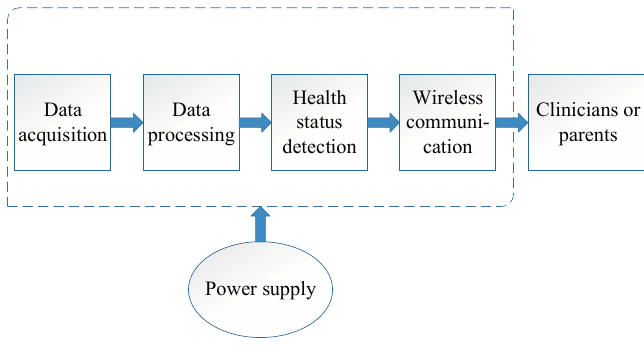
Figure 1. Framework of wearable sensor systems for